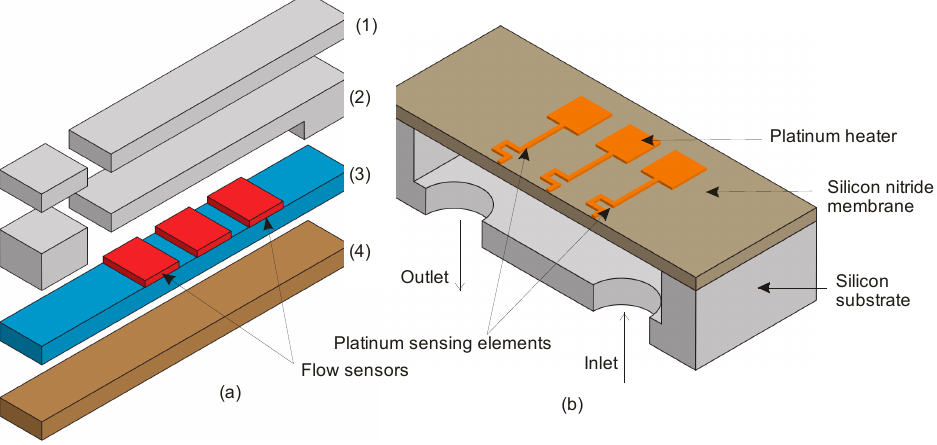
Figure 4. ( a ) Simplified stack segmented of thermal flow sensor developed by Lekholm et al. (1) Top layer for electrical and gas connections; (2) Second layer with gas channels, nozzles and vias for electrical connections; (3) Third layer with two propellant flow sensors, each containing a thruster and a central heater; (4) Stability layer during fabrication; ( b ) Calorimetric flow sensor reported by Palmer et al. where section along the channel of a device contains three platinum meanders placed on top of the silicon nitride membrane. Vias through the bottom silicon wafer serve as inlet and outlet to the gas channel etched in the top silicon